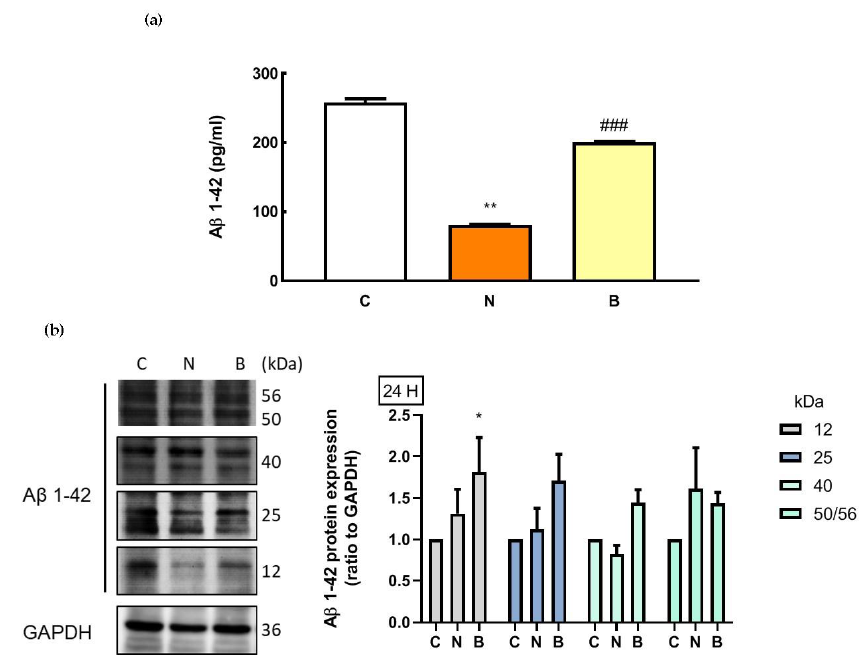
Figure 5. Effect of β -hydroxybutyrate on glucose-deprivation-induced changes in intracellular Aβ levels. Neuro-2a cells were cultured in the glucose-containing basal condition (C group), or in the condition of glucose deprivation with (B group) or without the presence of 10 mM β -hydroxybutyr- ate (N group) for 24 h. ( a ) Intracellular levels of monomeric Aβ were analyzed with an Aβ 1 – 42 -specific ELISA. ( b ) Changes in protein expression of oligomeric Aβ species were determined by Western blot analysis. Representative Western blot images are shown. GAPDH was used as a loading con- trol. Data are means ± SEM of 4 – 6 independent experiments, and each experiment was performed in simplicate. Statistical analysis was performed with one- way ANOVA followed by a Tukey’s HSD post hoc test. *, p < 0.05; **, p < 0.01 compared with the control group. ###, p < 0.001 compared with the N group. 4. Discussion Previous evidence has shown that hypoglycemia could lead to neuronal cell death, which contributes to cognitive impairment and dementia including AD [2,3,5]. However, whether hypoglycemia plays a role in Aβ accumulation is unclear. Ketone bodies have been shown to elicit beneficial effects that pertain to autophagy regulation [17,19] and neuroprotection against neurodegenerative diseases [34], but whether it has the potential to modulate Aβ levels is unknown. In the present study, a 24 h period of glucose depriva- tion exposure was able to induce Neuro-2a cell death, which is in agreement with previous studies demonstrating that neurotoxicity is the consequence of glucose deprivation [35]. Furthermore, we assumed that its underlying mechanisms might involve inadequate ATP supply, excessive ROS production, autophagy dysregulation and aberrant Aβ lev els in Neuro-2a cells under such a condition of stress. Our observation showing that glucose deprivation could cause an elevation in ROS production is in accordance with previous studies using different cells, such as primary neurons [24,36] and SH-SY5Y cell lines [35]. In addition, the reduced ATP levels and ATP/ADP ratios accompanied by increased neu- ronal cell death due to glucose deprivation in Neuro-2a cells suggests a possible associa- tion between insufficient ATP supply and neuronal cell death. It has been suggested that